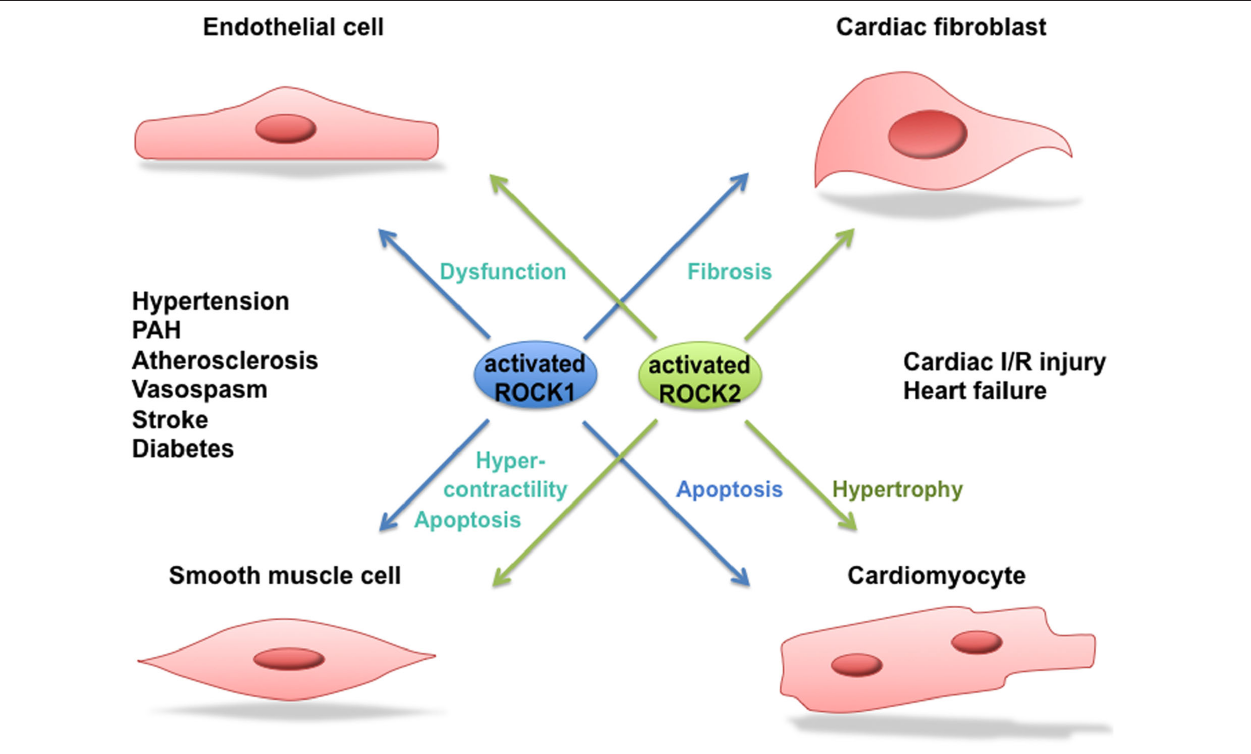
FIGURE 3 | Role of ROCK1 and ROCK2 in cardiovascular disease. Activated ROCK1 and ROCK2 play a pivotal role in processes leading to cardiovascular diseases such as hypertension, pulmonary arterial hypertension (PAH), atherosclerosis, vasospastic angina, stroke, diabetes, cardiac ischemia/reperfusion (I/R) injury and heart failure. Where possible, a distinction between the function of ROCK1 and ROCK2 in the different processes is